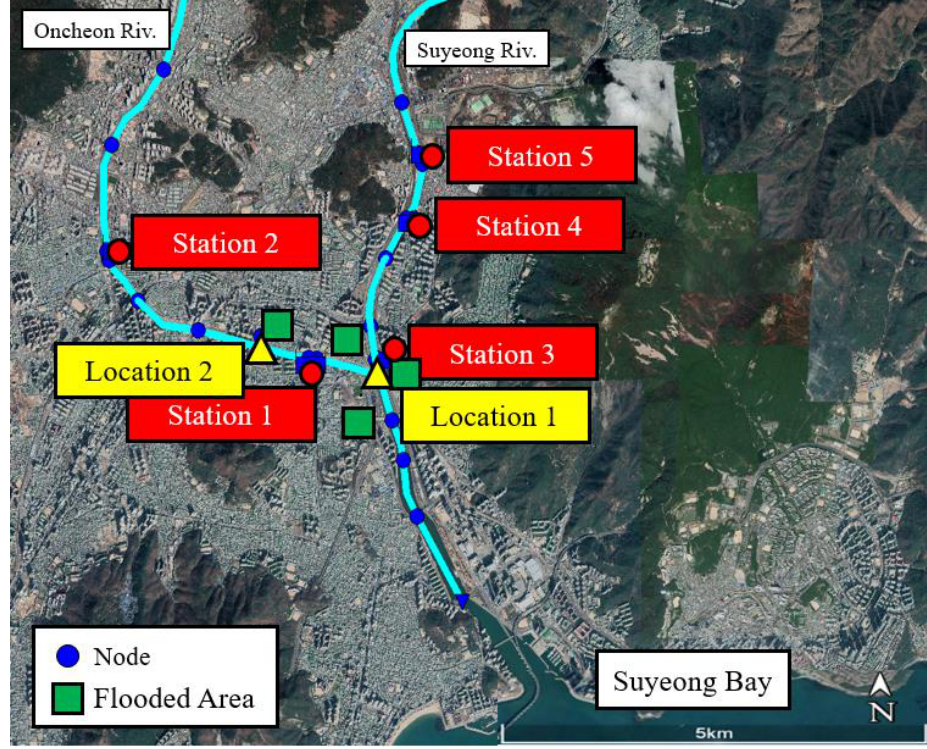
Figure 5. Locations of drainage pump stations based on flood analysis point(in SWMM). Table 3. Drainage pump station data.